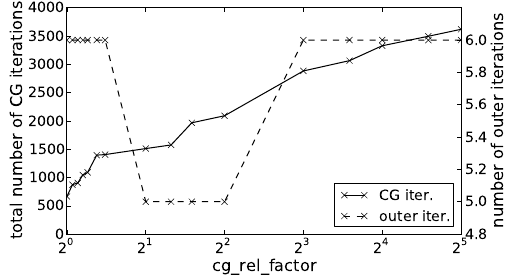
Fig. B1. The effect on parameterizing the conjugate gradient scheme on solving the baseline setup of Sect. 4.2. “cg rel factor” describes a multiplicative adjustment factor for modifying the re- quired reduction of the residuum after each outer iteration (increas- ing the required reduction of the residuum in case the cost function was reduced or vice